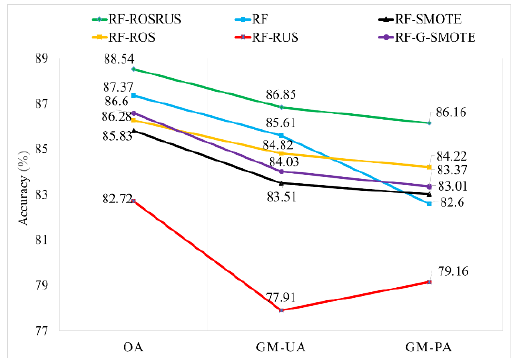
Figure 6. Accuracy assessment of the five resampling methods and the Scenario-4 classification method (i.e., RF with imbalanced samples) over Site-1.